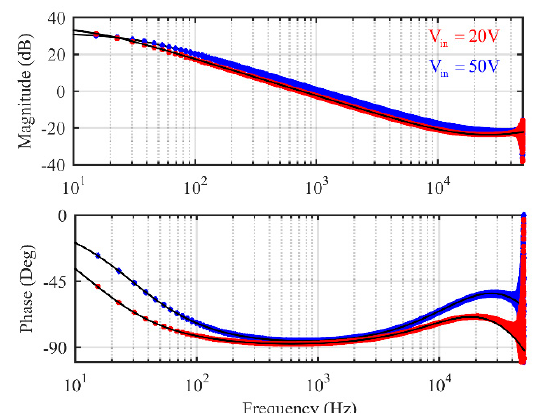
Figure 5. The predicted (solid black lines) and simulated (diamond and square marks) frequency responses of the control-to-output-voltage transfer functions at the input voltages of 20 V (red) and 50 V (blue).